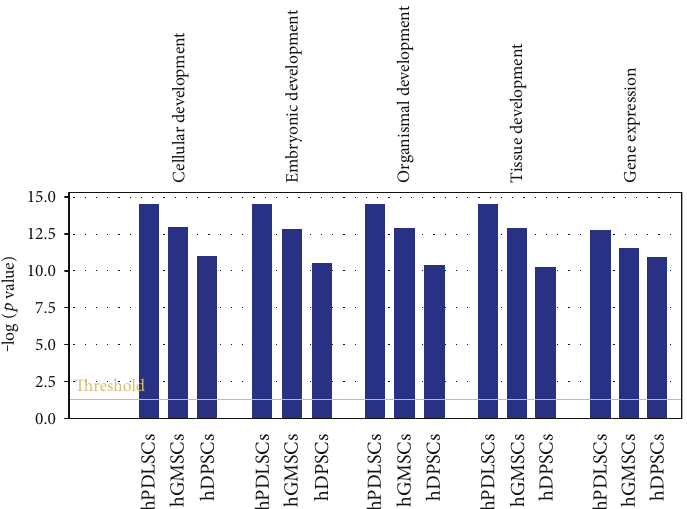
Figure 6: IPA functional analysis of the three gene datasets. IPA biological function analysis shows key functions modulated at P15 by the selected genes for hPDLSCs, hGMSCs, and